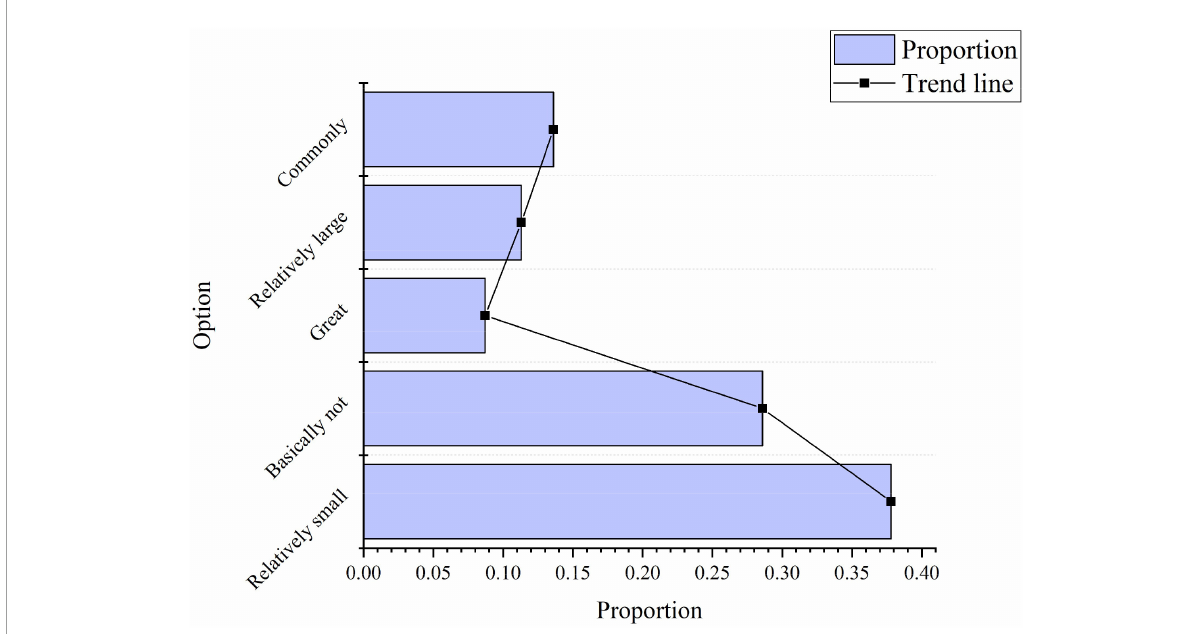
FIGURE10 Investigation of the proportion of entrepreneurial spirit in the construction of sports culture.